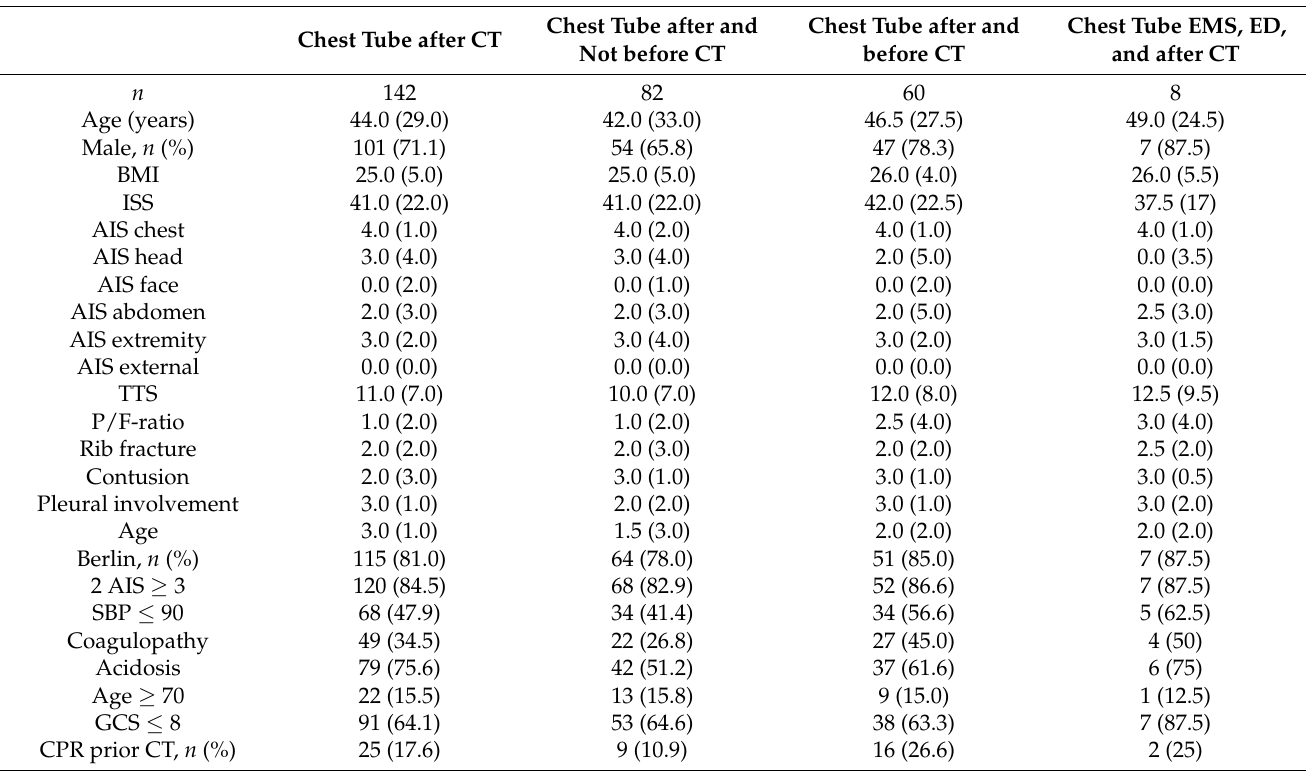
Table 4. Characteristics of patients with chest tube placement after initial computed tomography. Chest Tube after and Chest Tube after and Chest Tube EMS, ED, Chest Tube after CT Not before CT before CT and after